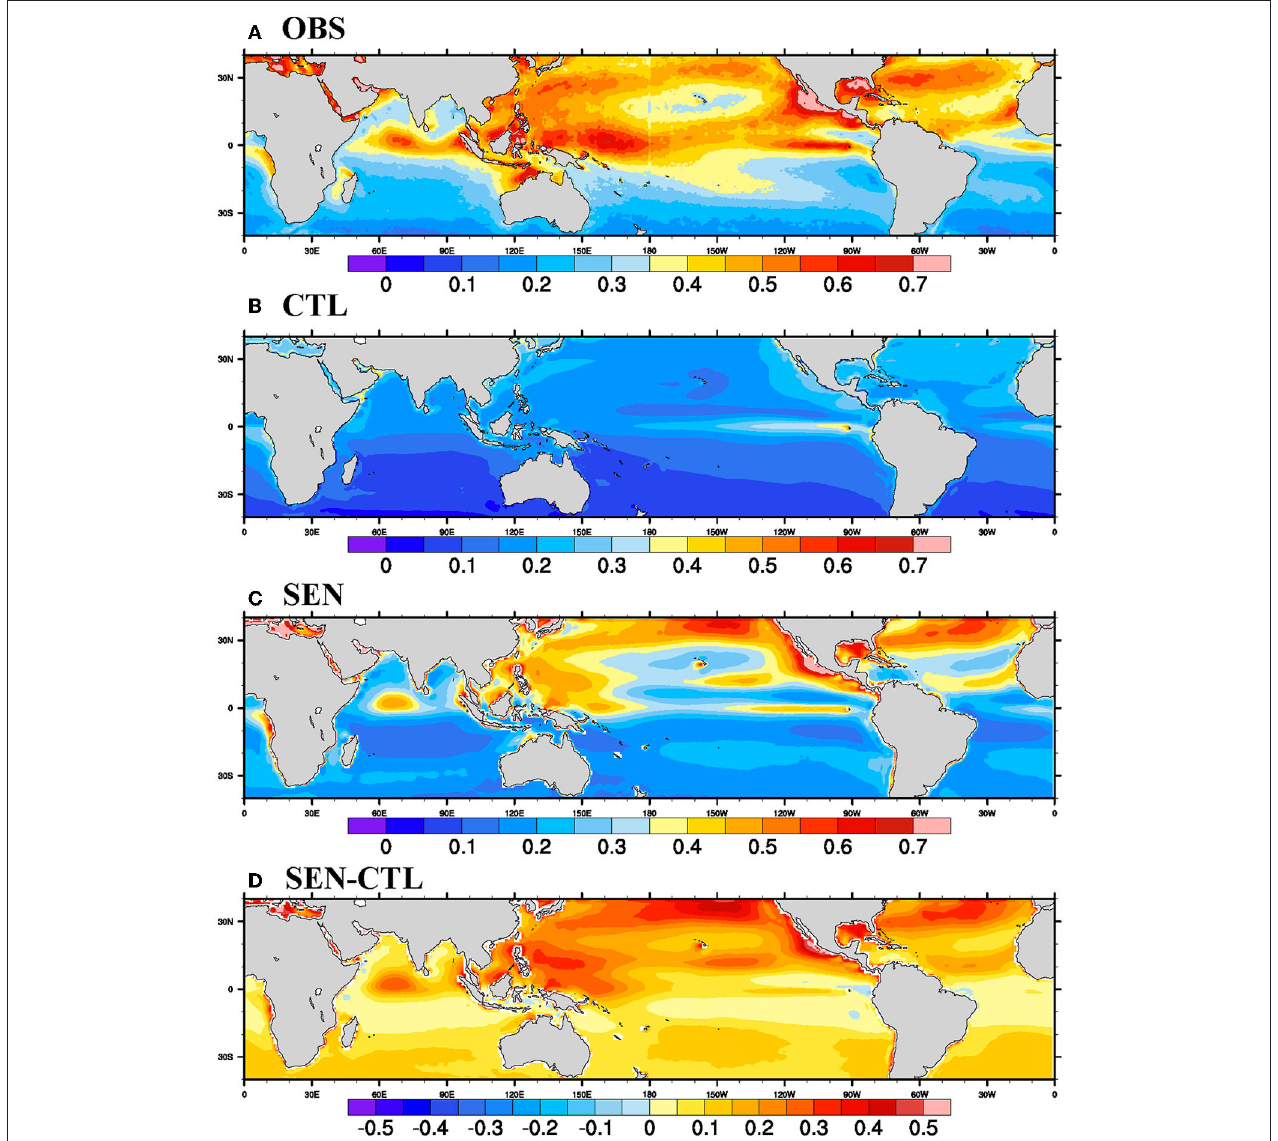
FIGURE 1 | Seasonal (JJAS) Mean diurnal range of SST ( dSST = maximum-minimum during 24-h cycle in ◦ C) from (A) observation (SEA-FLUX), (B) CTL, (C) SEN run, and (D) SEN minus CTL for the period 1998–2007.